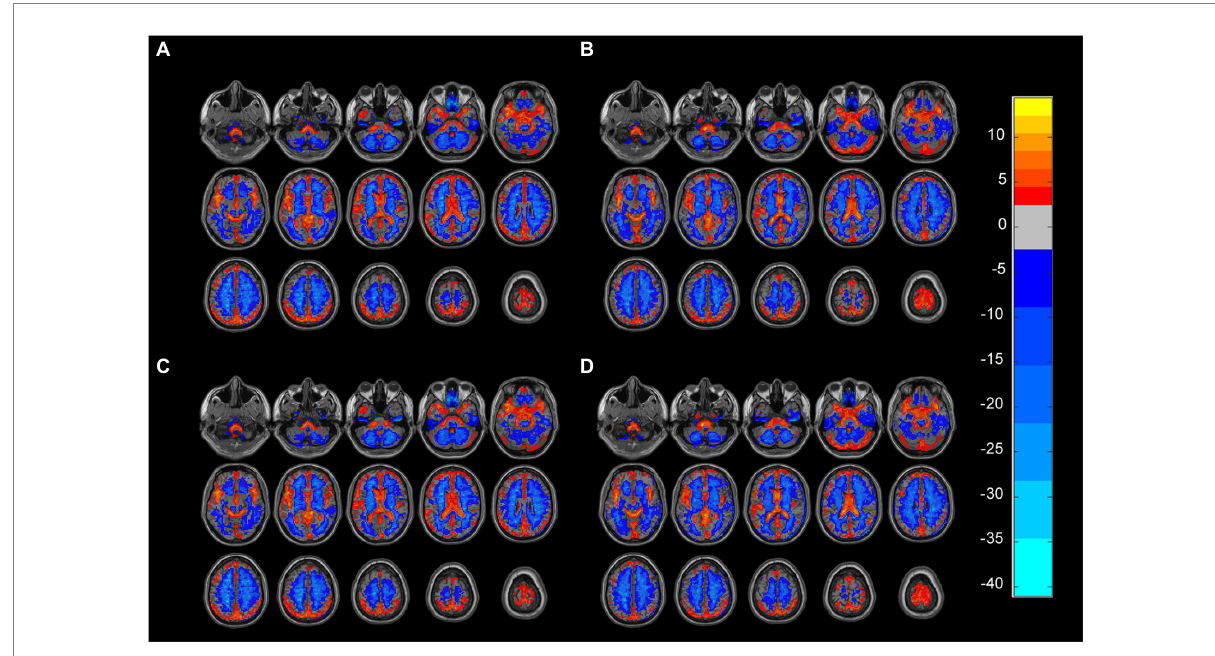
FIGURE 1 (A) Gray matter ALFF mapping of PD group (One-sample t -test, FDR, p < 0.05). (B) Gray matter ALFF mapping of HC group (One-sample t -test, FDR, p < 0.05). (C) White matter ALFF mapping in the PD group (One-sample t -test, FDR, p < 0.05). (D) White matter ALFF mapping in the PD group (One-sample t -test, FDR, p < 0.05). ALFF: amplitude of low-frequency fluctuations, PD: Parkinsons’s disease, HC: healthy control.